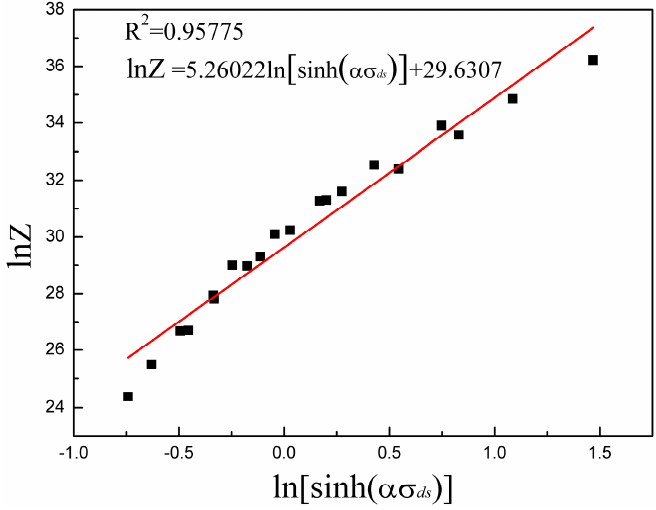
. . ε and ln σ ds ; ( b ) ln ε and σ ds ; ( c ) ln and . The linear curves are